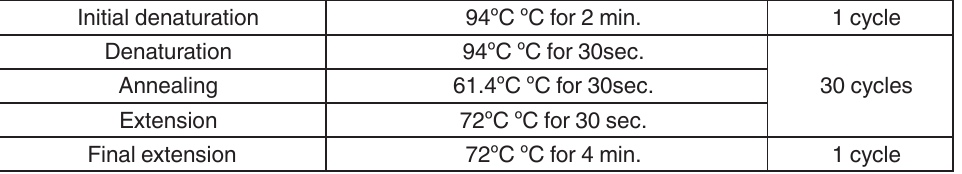
Table 1: Amplification cycle for Campylobacter foetus subsp. foetus and Campylobacter foetus subsp. venerealis.